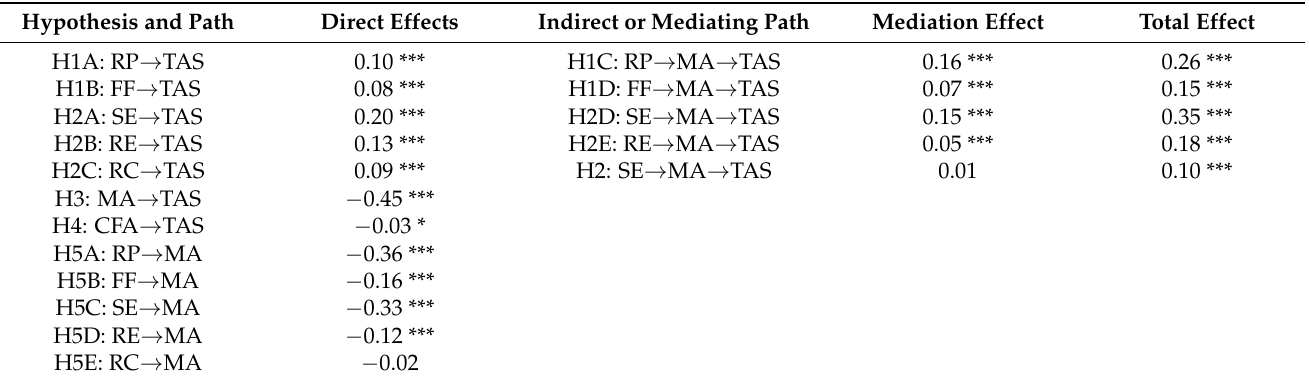
Figure 4. Path modeling results (SEM standardized coefficients). Only the direct effects are reported. Table 6. Direct, indirect (mediation), and total effects of predictors on flood adaptation strategies.